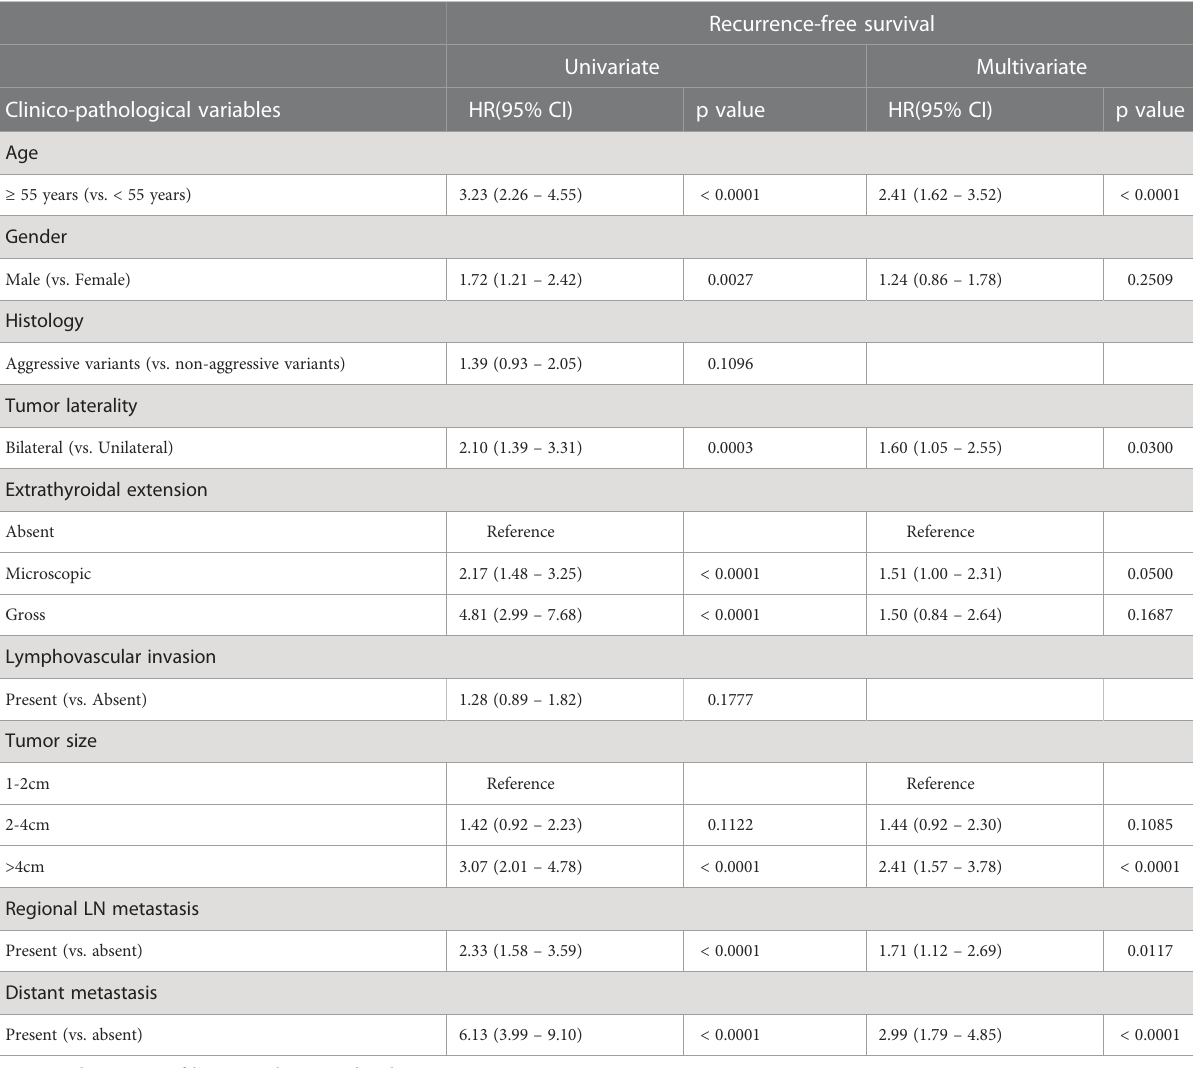
TABLE 3 Cox proportional hazards model for predictors of recurrence-free survival (RFS) in multifocal PTC.